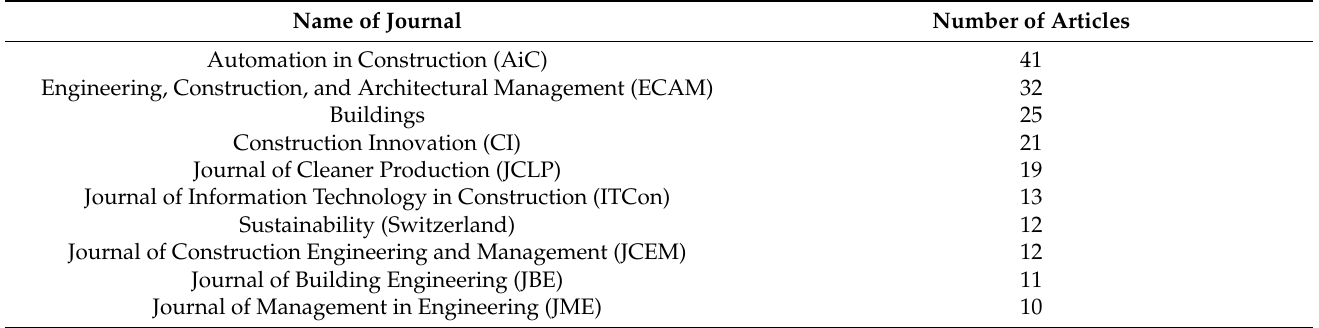
Table 1. Journal contribution based on articles published (top ten).